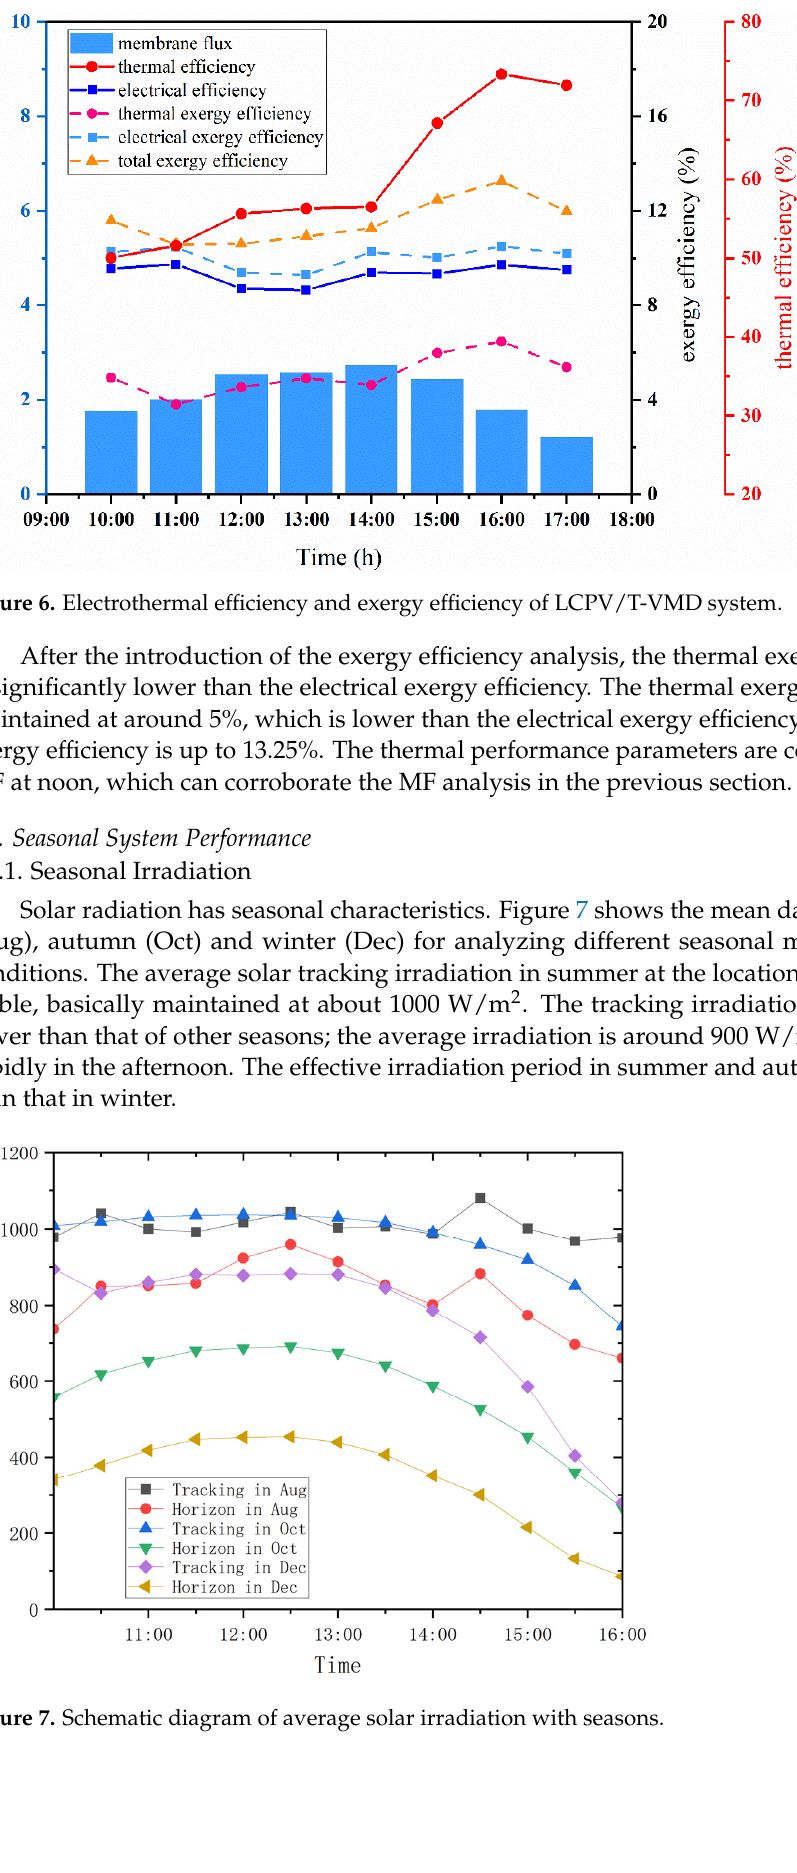
Figure 7. Schematic diagram of average solar irradiation with